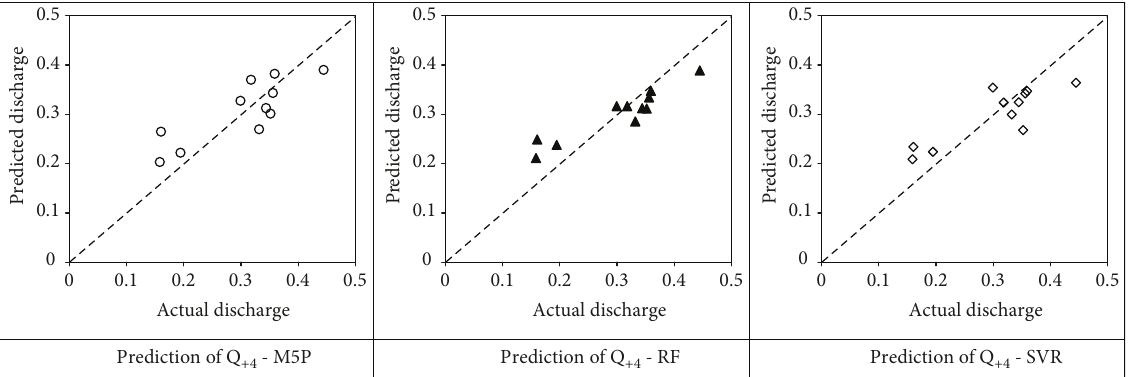
Prediction of Q + 4 - M5P Prediction of Q + 4 - RF Figure 18: Comparison between predicted and observed discharges (m 3 /s), 6-month input.